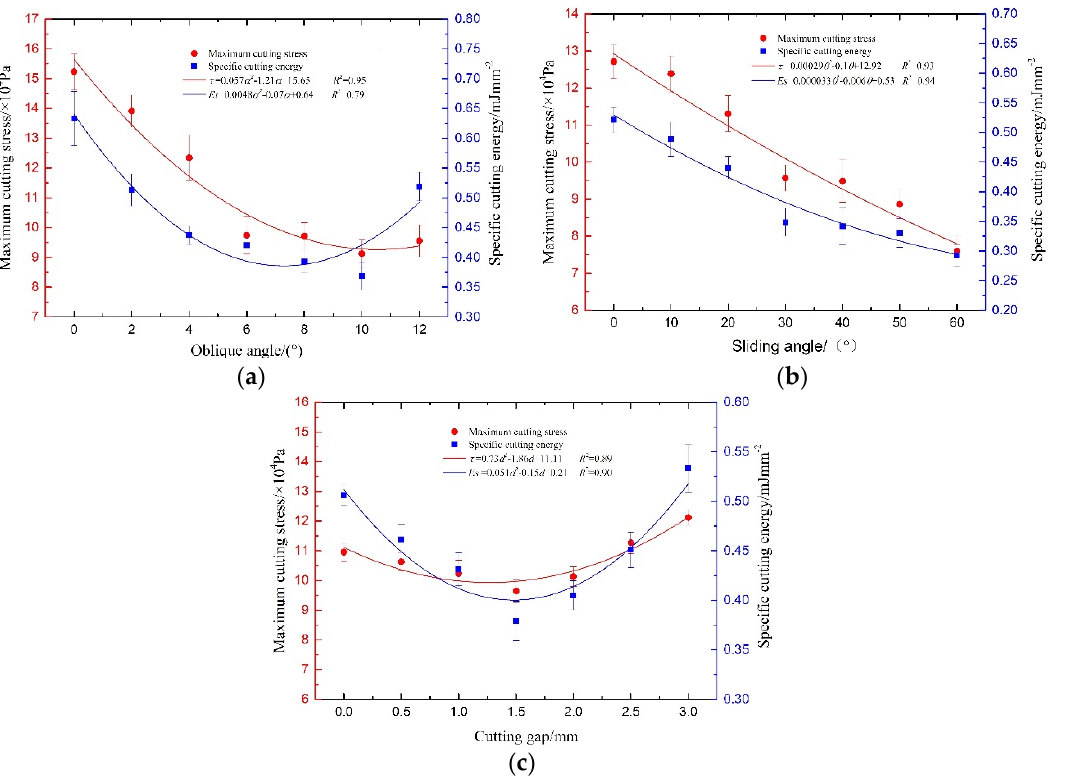
Figure 5. Effect of different factors on maximum cutting stress and specific cutting energy. ( a ) Effect of different oblique angles on maximum cutting stress and specific cutting energy. ( b )Effect of different sliding angles on maximum cutting stress and specific cutting energy. ( c ) Effect of different cutting gaps on maximum cutting stress and specific cutting energy.